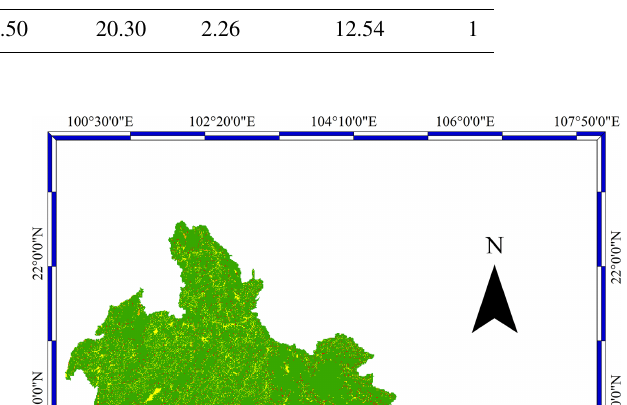
Table 1. AHP pairwise comparison matrix ( D i,k ) with the weight of each criterion. Option B ( k )/option A ( i ) Flood Land Landslide Climate Climate Weight use change change ( w i ) change leading to leading to floods landslides Flood 1.00 4.20 7.10 0.71 4.10 0.33 Land use change 0.24 1.00 3.60 Landslide 0.14 0.28 Climate change leading to floods Climate change leading to landslides 0.24